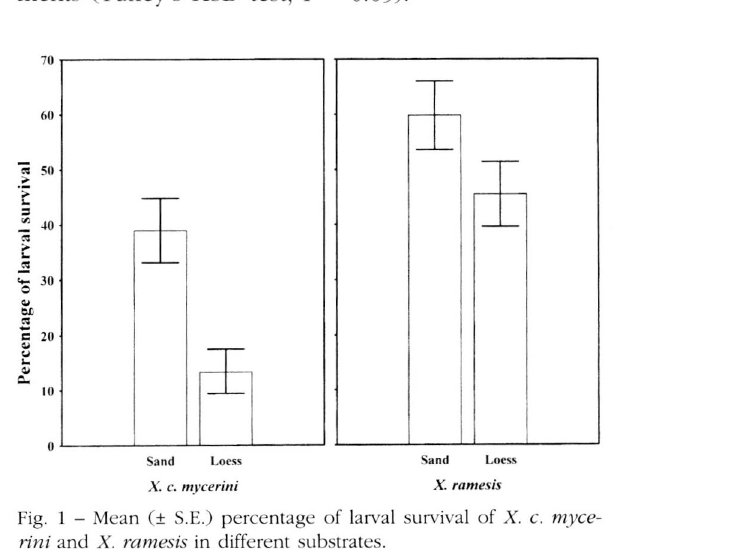
Fig. 1 - Mean (± S.E.) percentage of larval survival of X. c. myce rini and X. ramesis in different